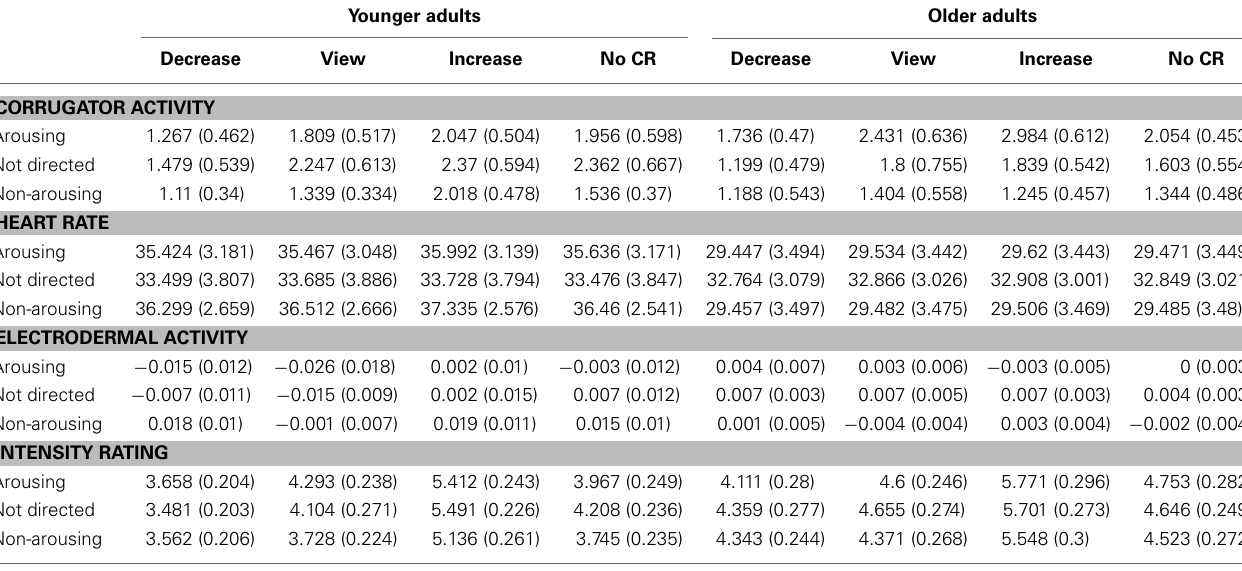
Table 4 | Estimates of emotional responding for each measure as a function of Cognitive Reappraisal (CR) instruction, gaze direction, and age